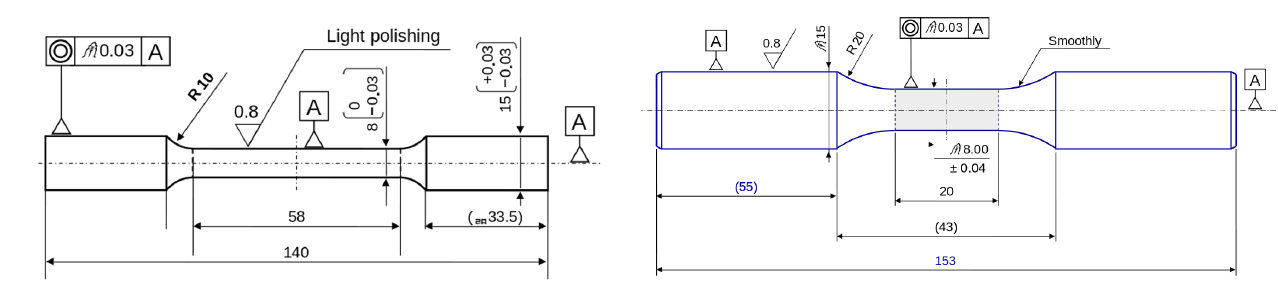
Figure 2. The drawings of specimens used in tension ( left ) and fatigue ( right )